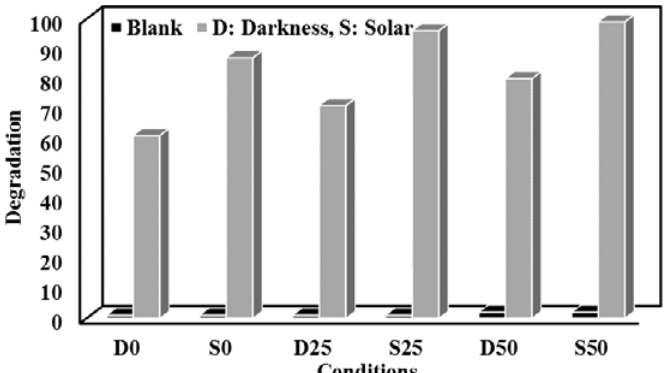
Fig. 11. Results of methyl orange destruction under darkness (D) and solar (S) conditions after 60 min. The studies were carried out using 6.5 ppm aqueous solutions of methyl orange at pH = 3.1 and in the presence of 10 mg catalyst at 0, 25 and 50°C. The numbers that follow “D” and “S” are related to the temperature of degradation. Blank runs, samples without a catalyst, are also